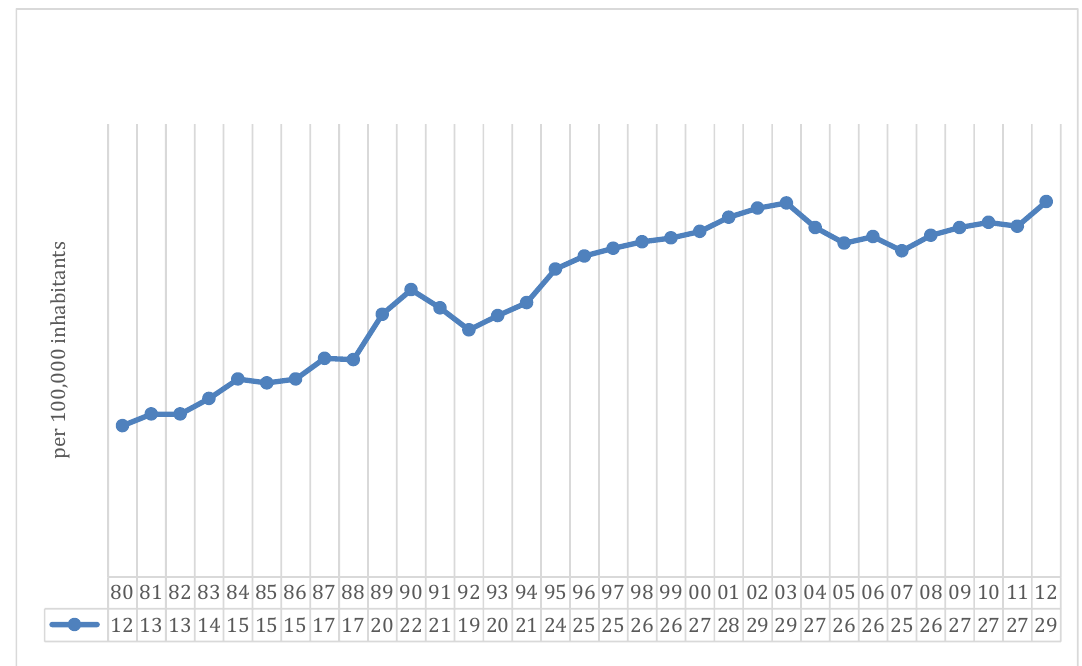
Figure 1: Homicide rates in Brazil (per 100,000 inhabitants) 1980 ‐ 2012 Source: Waiselfisz